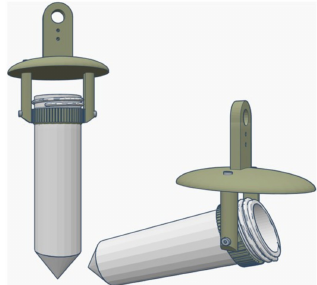
Figure 1. Engineering diagram of the 3D-printed water sampler designed to hold a sterile 50 mL conical tube. The tube had a swinging bucket design (right), and was attached to the drone via a carabiner on a nylon string.